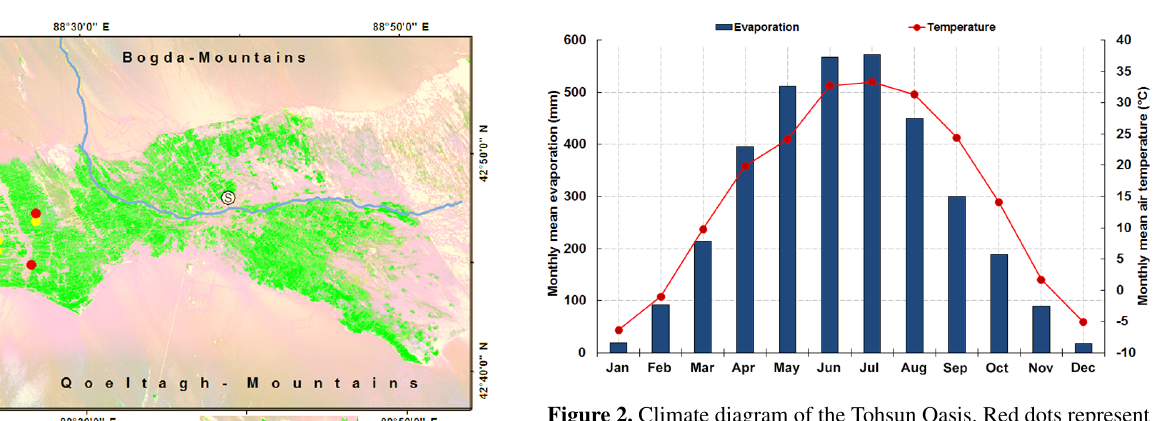
Figure 2. Climate diagram of the Tohsun Oasis. Red dots represent monthly means of air temperature, and blue bars are monthly means of potential evaporation for the period 1971–2005 (data source: Xinjiang Meteorological Bureau, Urumqi,